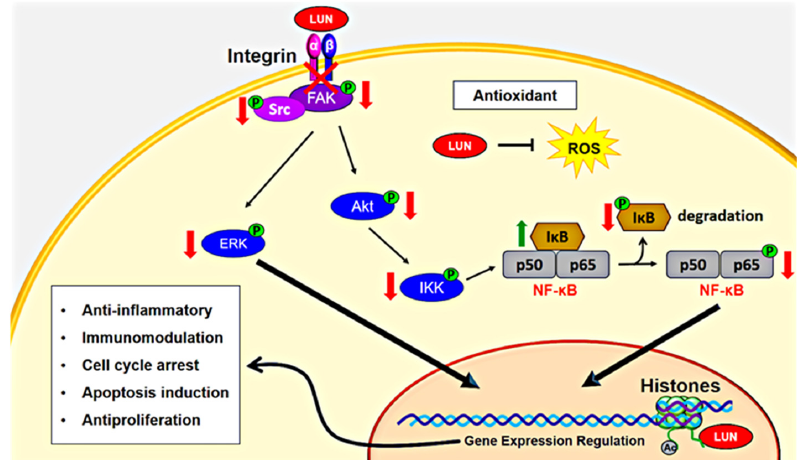
Figure 3. Simplified lunasin mechanism of action against cancer. Lunasin (LUN) has antioxidant capacity, lowering intracellular reactive oxygen species (ROS) levels. Furthermore, lunasin has epigenetic effects, binding to the N-terminus of deacetylated histones H3 and H4, as well as regulating acetylation (Ac) and deacetylation of specific lysines. Lunasin also binds to and antagonizes integrin-mediated signaling pathways, such as Ras/MEK/ERK and PI3K/Akt. Lunasin antagonism on integrins decreases FAK, Src, ERK, and Akt phosphorylation. Integrin antagonism also allows lunasin to inhibit the NF- κ B pathway by limiting I κ B kinase (IKK) activation. The IKK complex phosphorylates and promotes I κ B degradation, releasing p50 and p65 subunits of NF- κ B for nuclear translocation and the activation of gene expression. Thus, the epigenetic and integrin-